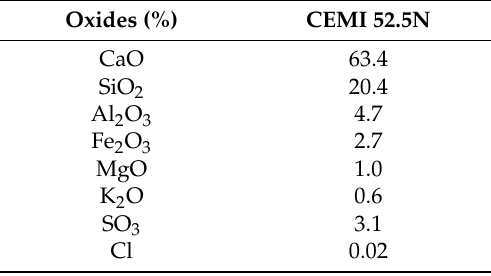
Table 1. Chemical composition of the